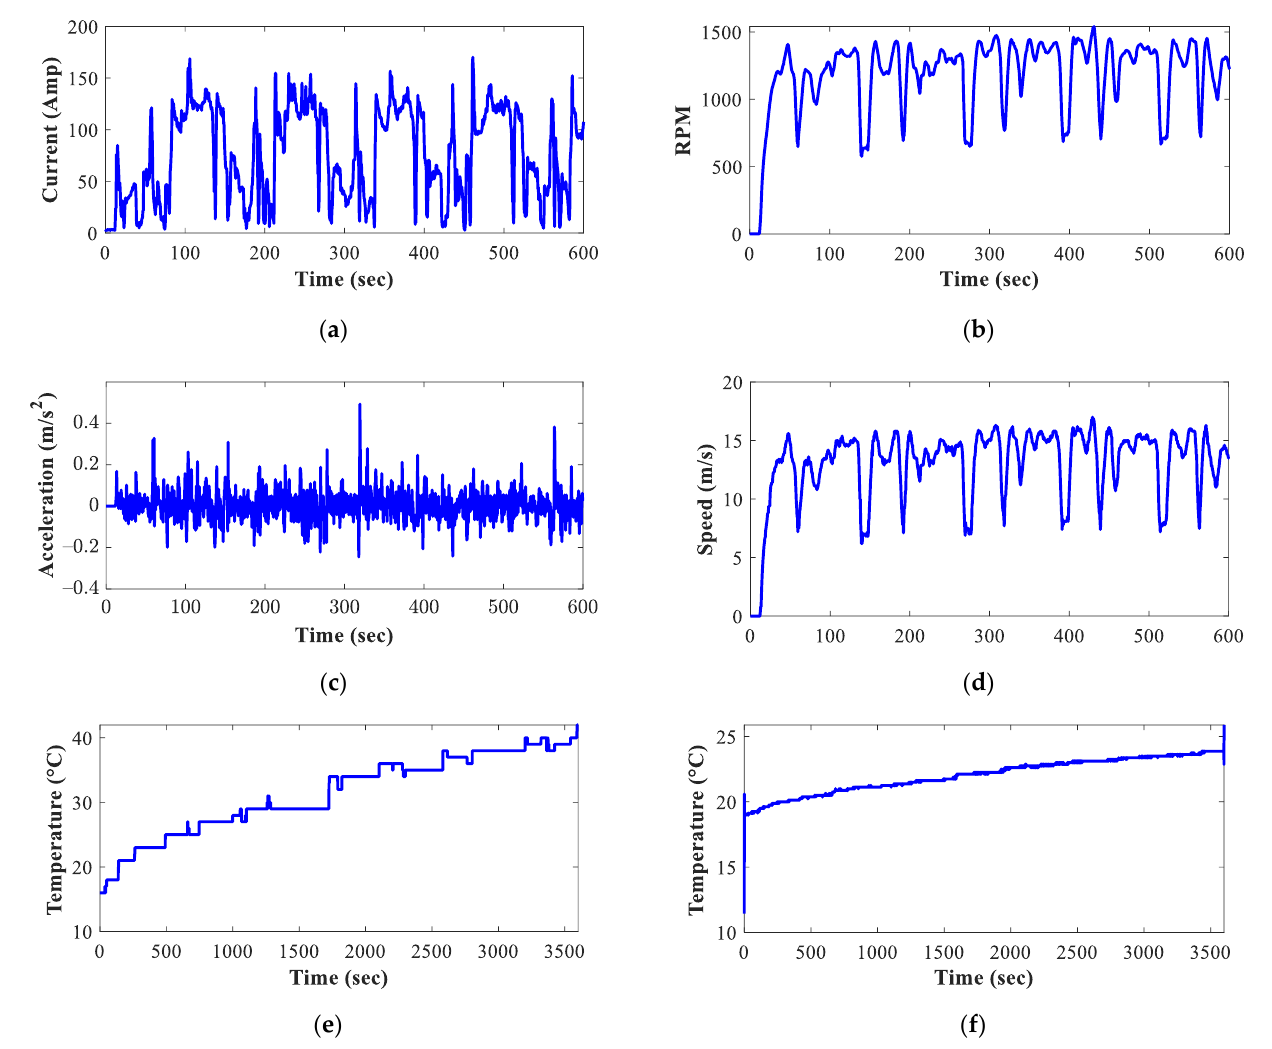
Figure 4. Set of signals acquired during the experimental tests: ( a ) motor current, ( b ) motor RPMs, ( c ) vehicle acceleration, ( d ) vehicle speed, ( e ) motor temperature, and ( f ) average battery tempera- ture.